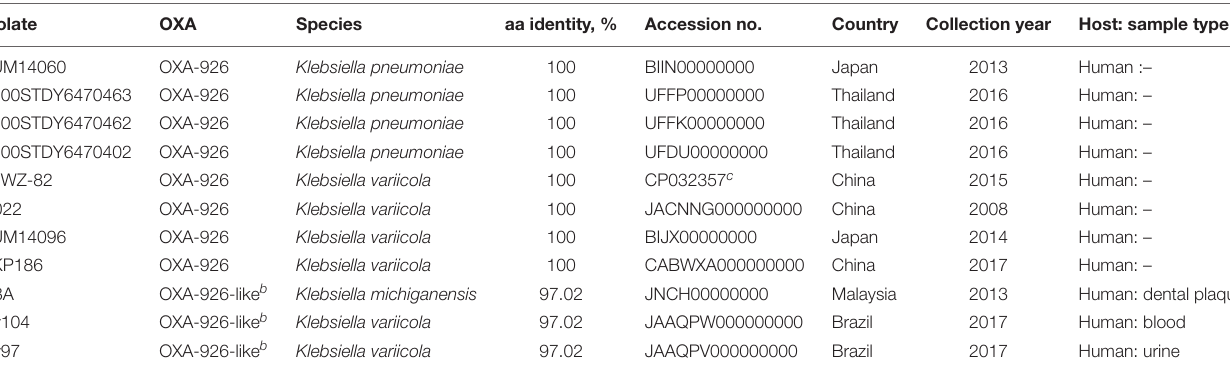
TABLE 4 | Genomes containing bla OXA − 926 or bla OXA − 926 -like genes in GenBank a . Isolate OXA Species aa identity, % Accession